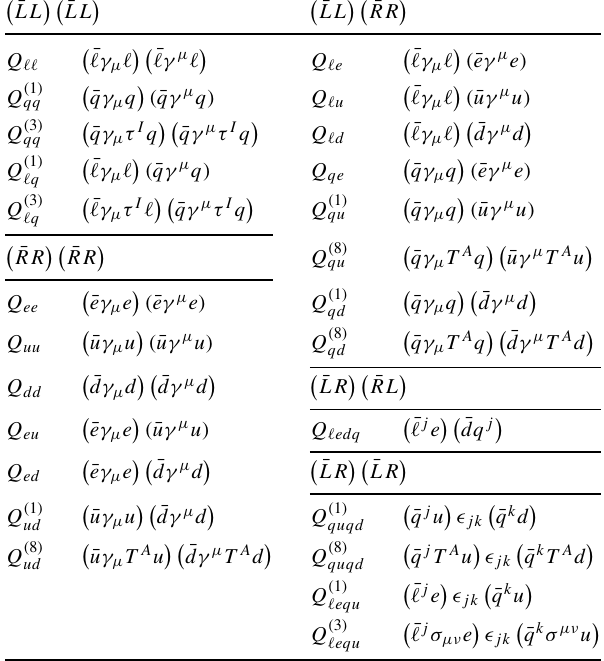
Table 5 SMEFT mixed operators involving bosons and fermions ψ 2 ϕ 3